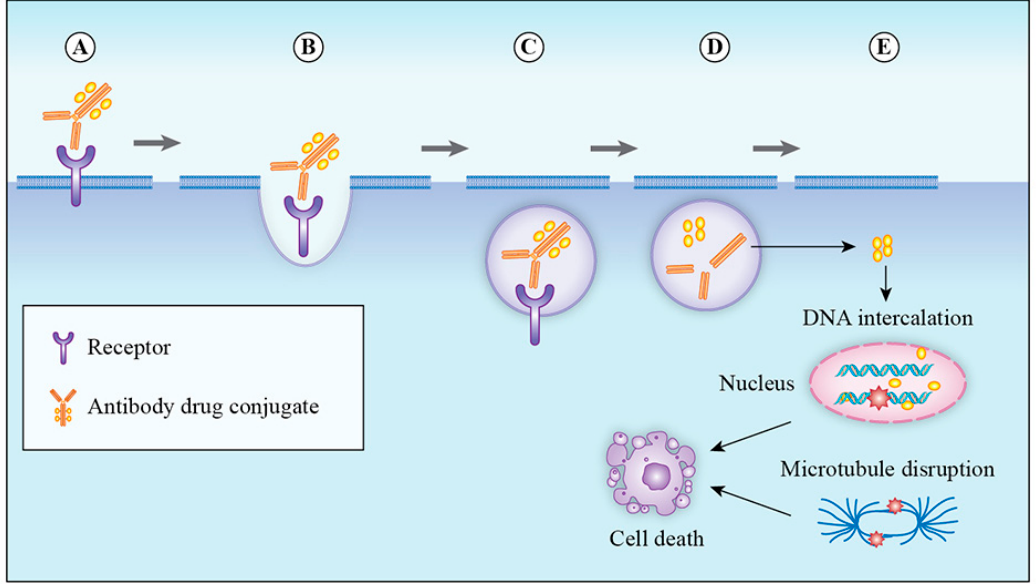
Figure 2. Mechanism of action: ( A ) binding of ADC therapy to target cell surface antigen; ( B ) the antibody–drug conjugate undergoes receptor-mediated endocytosis; ( C ) the antigen–antibody–drug complex is delivered into the lysosomal compartment; ( D ) degradation of the antigen–antibody–drug complex occurs in an acidic and proteolytic enzyme-rich environment, resulting in the intracellular release of the drug; ( E ) intracellular release of the cytotoxic compound, resulting in cell